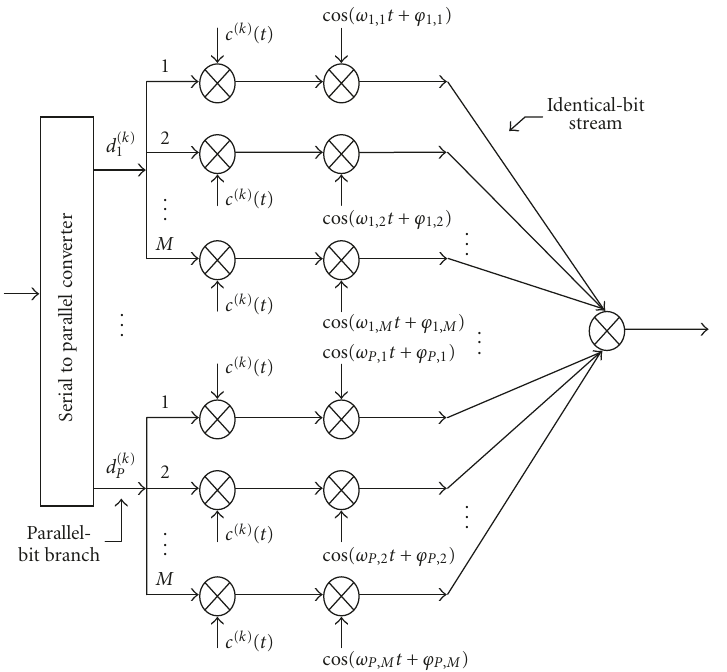
Figure 1: Illustration of signal transmission for user k